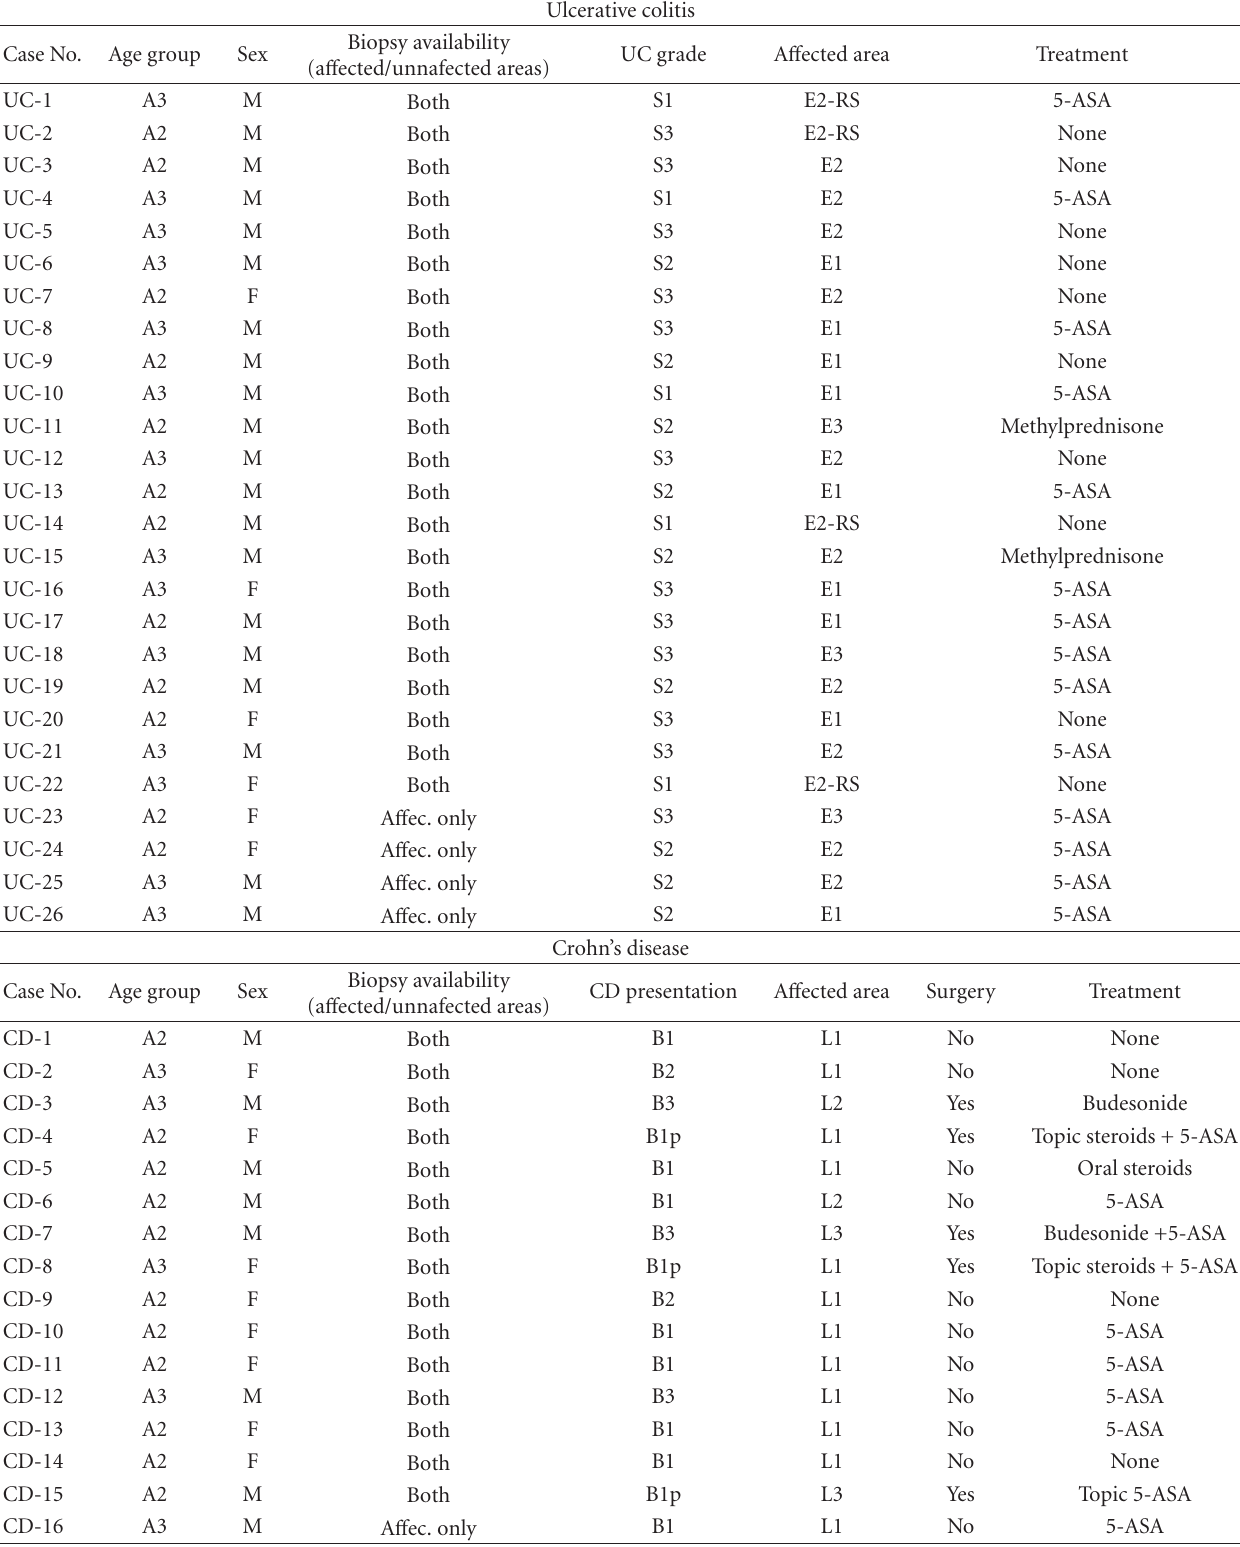
Table 1: Clinical information from IBD patients included in the study according to the Montreal classification [13]. Age groups: A2 17–40 years, and A3 > 40 years. UC a ff ected area: E1 proctitis, E2 left colitis or rectosigmoditis (E2-RS), and E3 pancolitis. UC grade: S1 mild colitis, S2 moderate colitis, and S3 severe colitis. CD a ff ected area: L1 terminal ileon, L2 colon, L3 ileocolonic, and “p” periananal a ff ectation. CD presentation: B1 nonstricturing and nonpenetrating (formerly known as inflammatory), B2 stricturing, and B3 penetrating. Ulcerative colitis Case